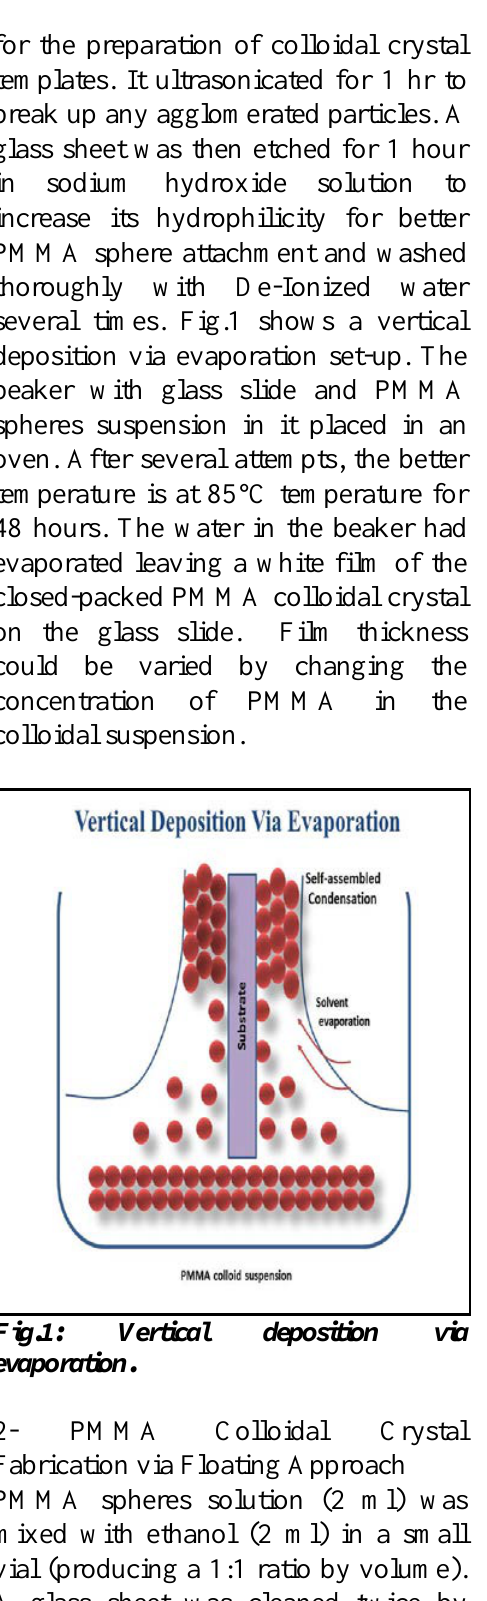
Fig.1: Vertical deposition via evaporation.